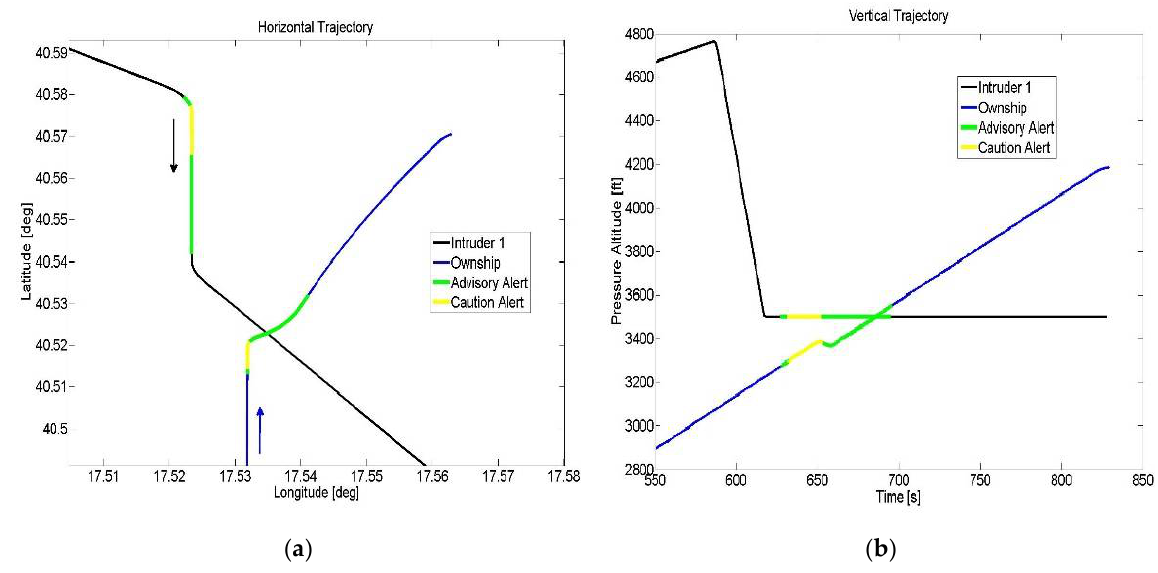
Figure 19. ( a ) Horizontal trajectory of the head-on encounter. After the activation of the Caution alert, the RP executes a right turn maneuver supported by the RWC indications on the CDTI, only informing the controller of the executed maneuver as he is flying under an uncontrolled airspace. ( b ) Vertical trajectory of the encounter. The RPAS is climbing, while the intruder is in level flight during the RWC alert activations. No vertical maneuver is executed by either aircraft involved in the encounter.